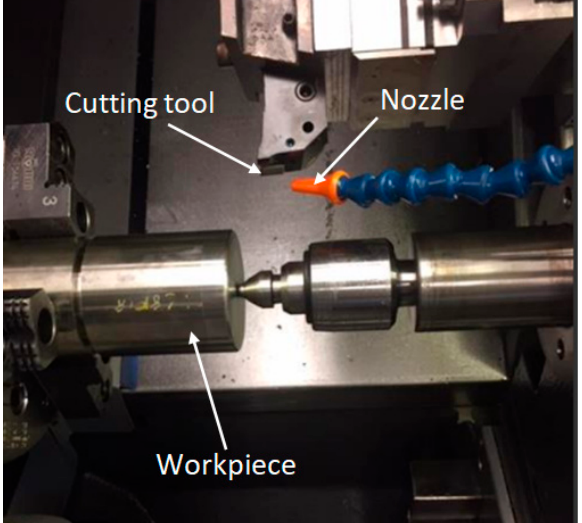
Figure 1. Experimental setup view.